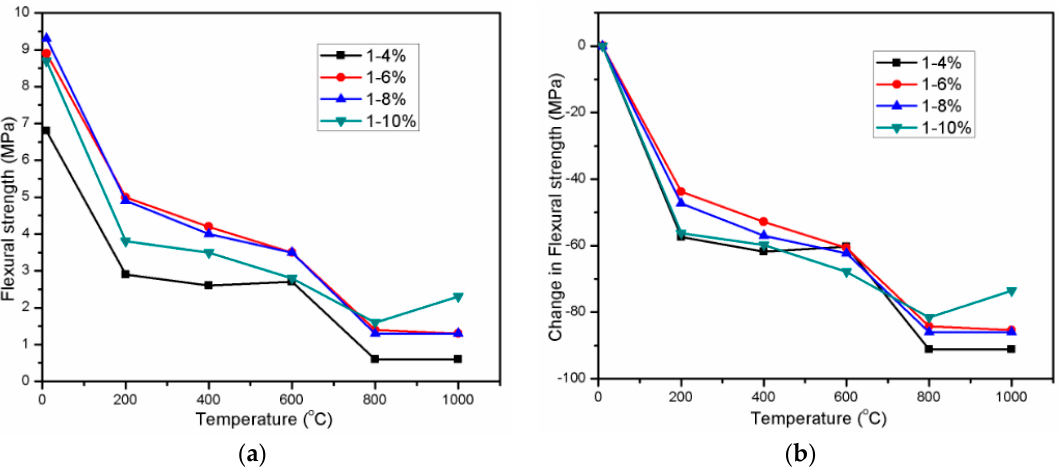
Figure 6. Residual flexural strength ( a ) and change in flexural strength ( b ) of AAS mortar.